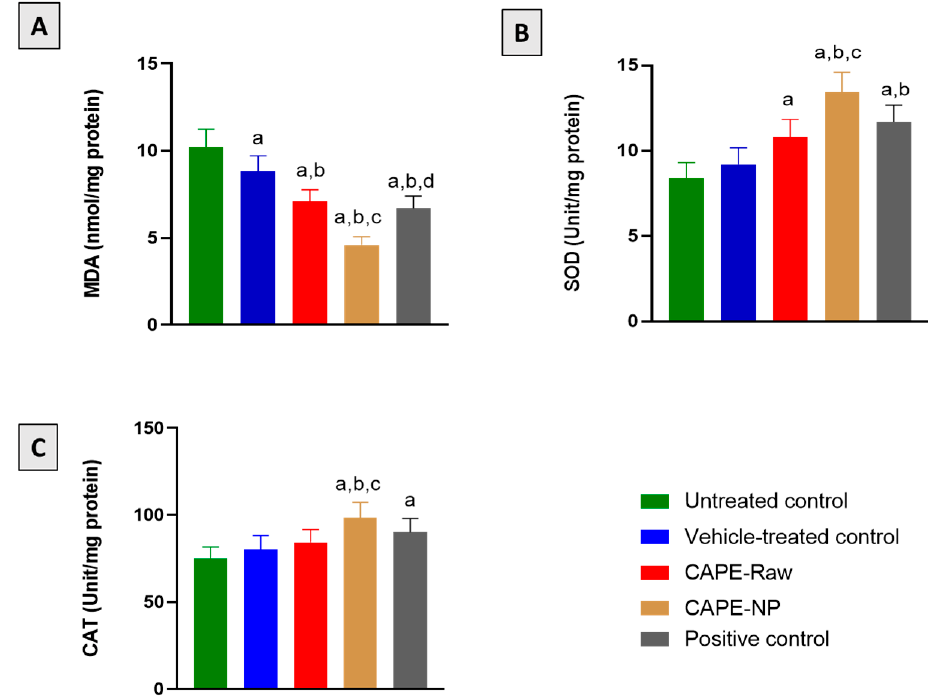
Figure 5. Effects of CAPE-NPs on oxidative status markers ( A ) MDA, ( B ) SOD, and ( C ) CAT. Data are expressed as mean (n = 6) ± SD. (a) Significantly different from untreated control at p < 0.05, (b) significantly different from vehicle-treated control at p < 0.05, (c) significantly different from CAPE-raw at p < 0.05, and (d) significantly different from CAPE-NP at p < 0.05.